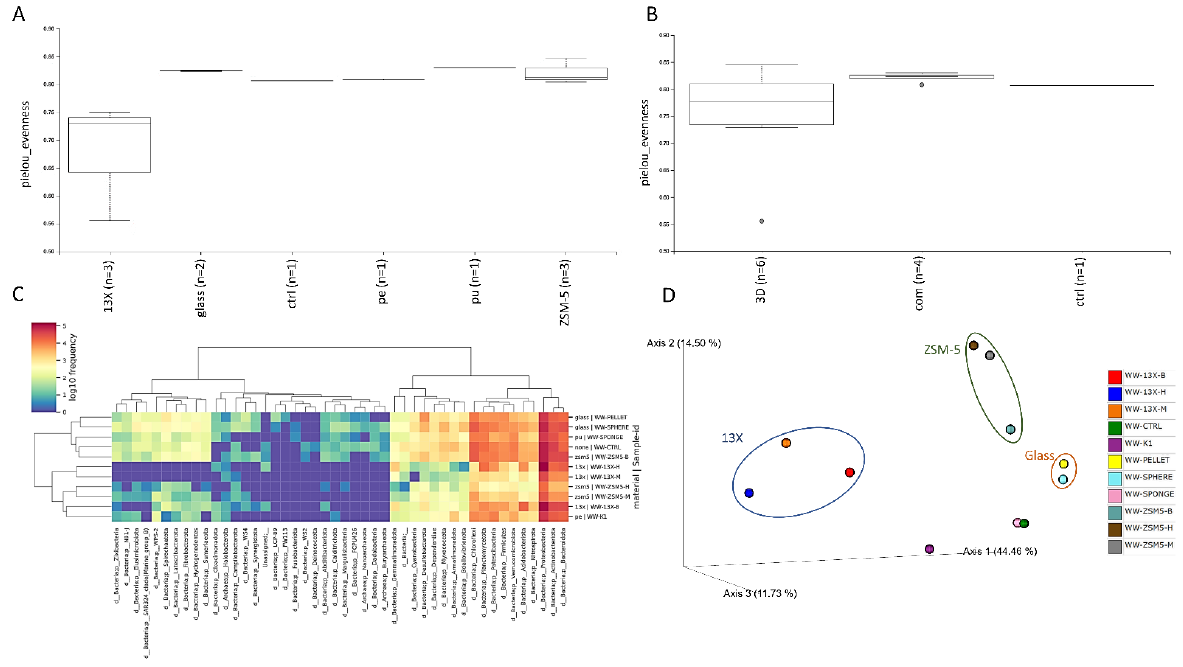
Figure 11. Core metrics results of bioinformatics of WW samples. ( A ). Alpha-diversity boxplot of different material groups using the metric pielou-eveness. ( B ). Alpha-diversity boxplot of different source groups using the metric pielou-eveness. ( C ). Heatmap of phyla. ( D ). Beta-diversity plot using the metric Bray-Curtis.